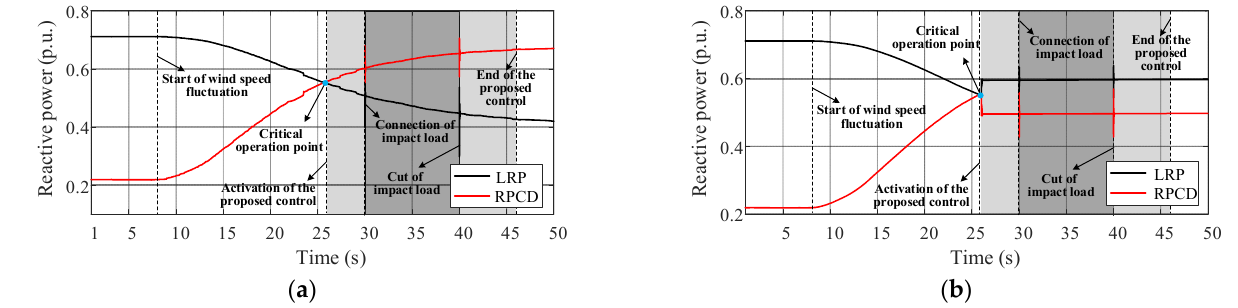
Figure 16. Real-time LRP and RPCD curves in case I. ( a ) Constant voltage control. ( b ) Active voltage coordinate control with HESS.